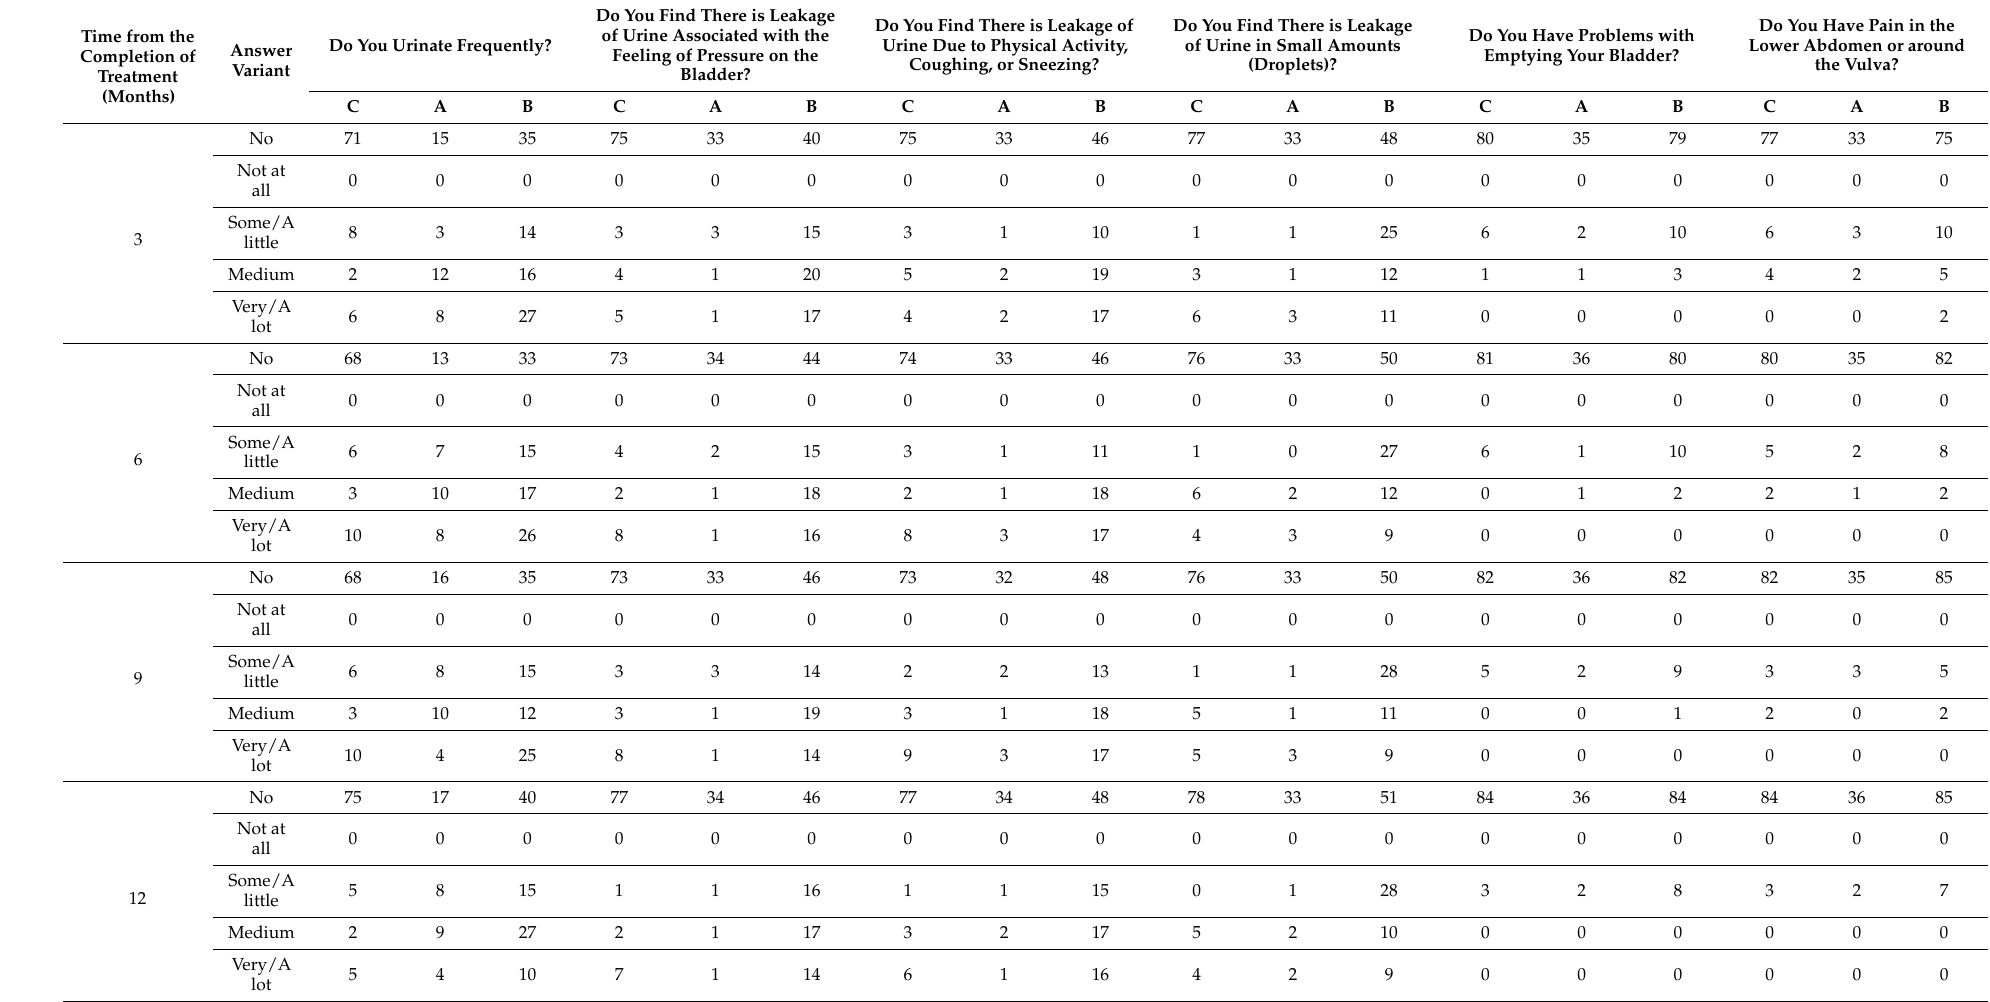
Table 3. Results of the Urogenital Distress Inventory (UDI-6)